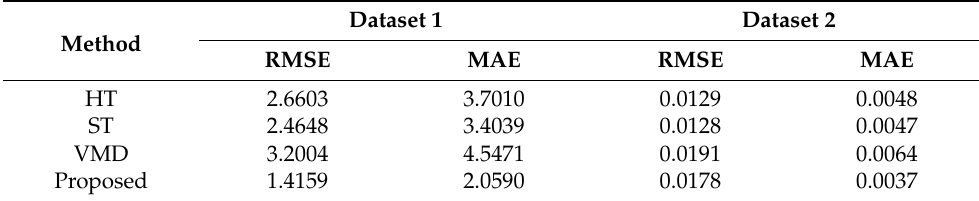
Table 3. Denoising performance comparison of different methods.